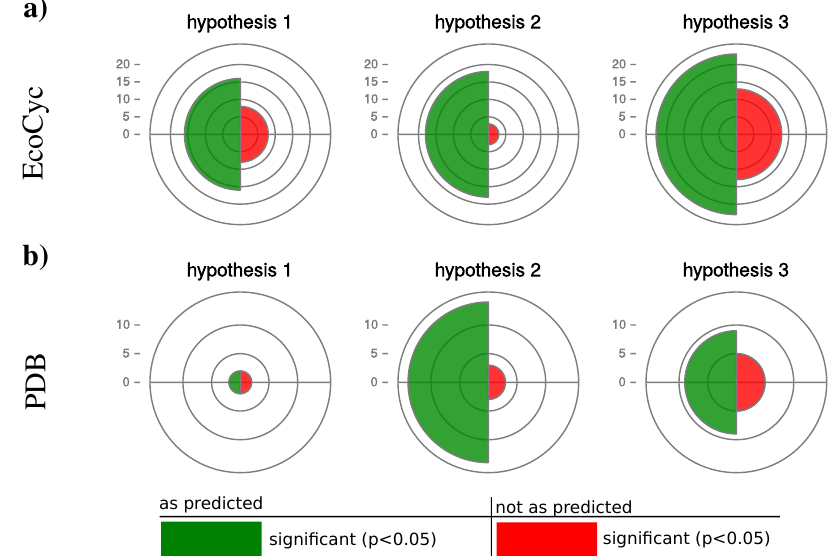
Figure 5. Summary of Validation results. The number of protein complexes confirming (green) or rejecting (red) our hypotheses are depicted as polar area diagrams where the size represents the count number. In ( a ) the results based on the protein complexes retrieved from the EcoCyc database and in ( b ) from the PDB database are